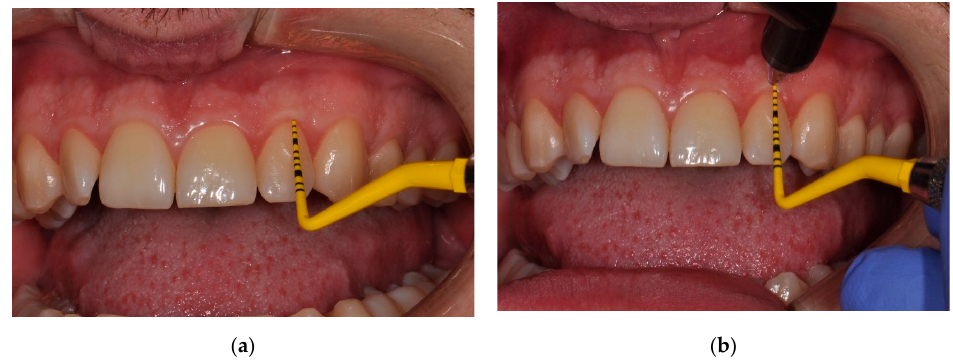
Figure 2. Ultrasonic gingival thickness measurement with the Pirop G ® device: ( a ) probing depth measurement, ( b ) supracrestal gingival tissue measurement—the center of the probe head is situated 1 mm apically from CAL.